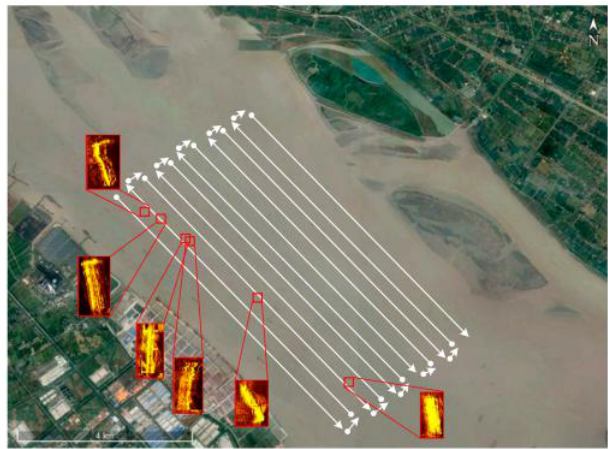
Figure 24. The recognition result of container